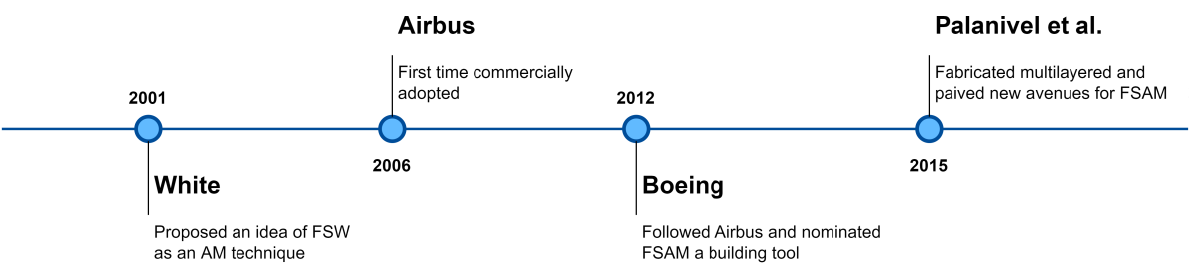
Figure 3. Timeline and development of FSAM [43,45,47,48].